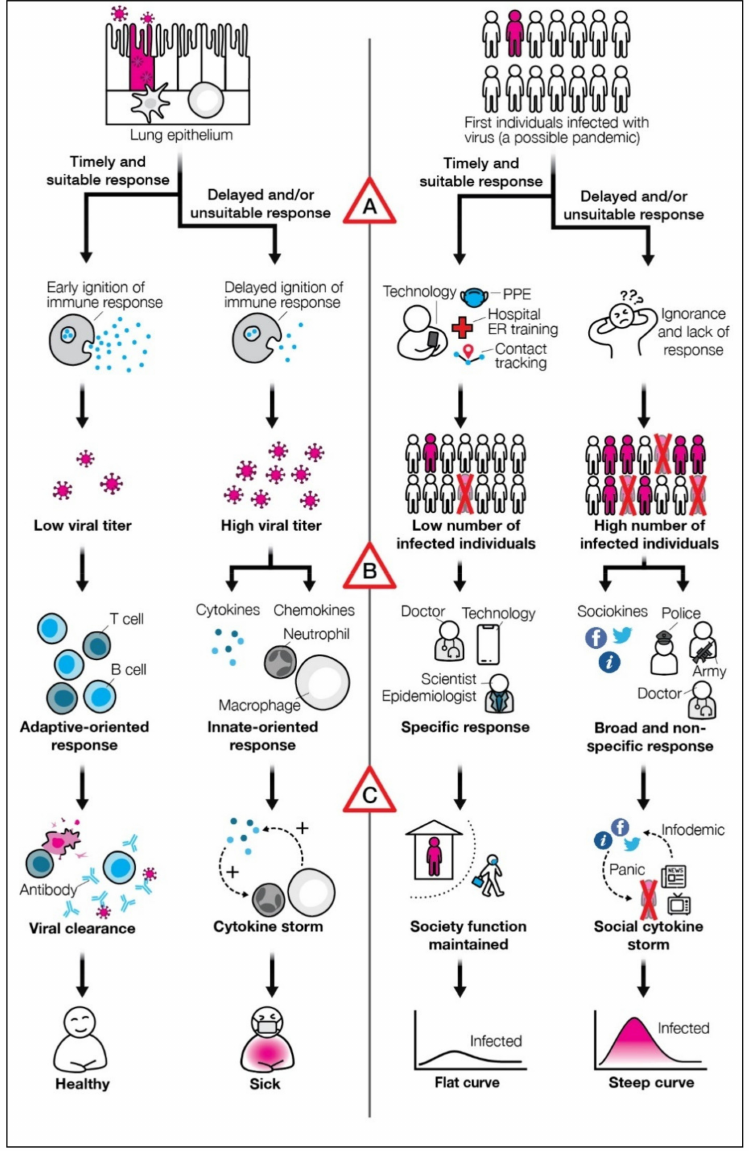
Figure 1. Parallels between individual and societal effective and ineffective responses to an invad- ing pathogen. Triangles denote the factors determining the effectiveness of societal response to a pathogen. ( A )—The quick employment of adaptive-like strategies to cope with a disease spreading throughout the society. ( B )—Enabling productive coaction within the society or globally, by employ- ing effective decision-making processes. ( C )—Quick inhibition of positive feedback loops generated by hazardous or false